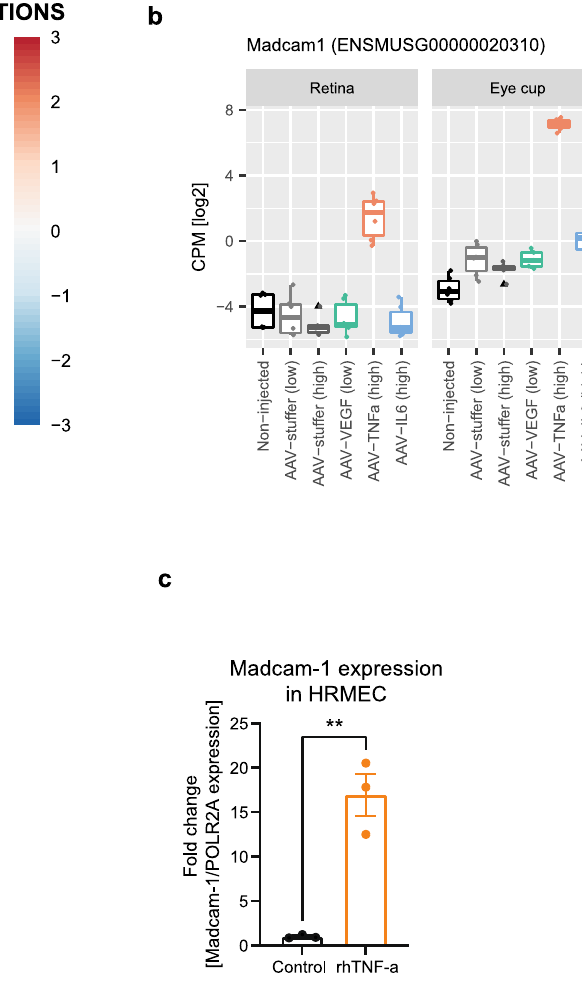
Cell adhesion molecules including Madcam‑1 are specifically regulated by TNF‑α.